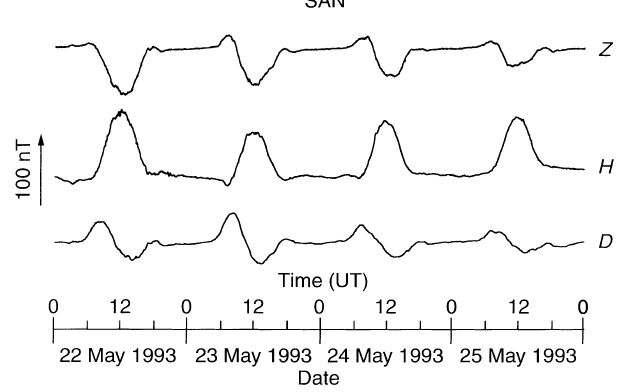
Fig. 3. Minute values of geomagnetic daily variations of horizontal (east D , north H ) and vertical Z components at San during a few consecutive quiet days in